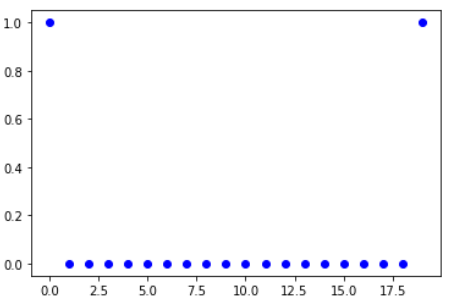
Figure 3. Display the error vector for the true solution with two reference points at the ends.